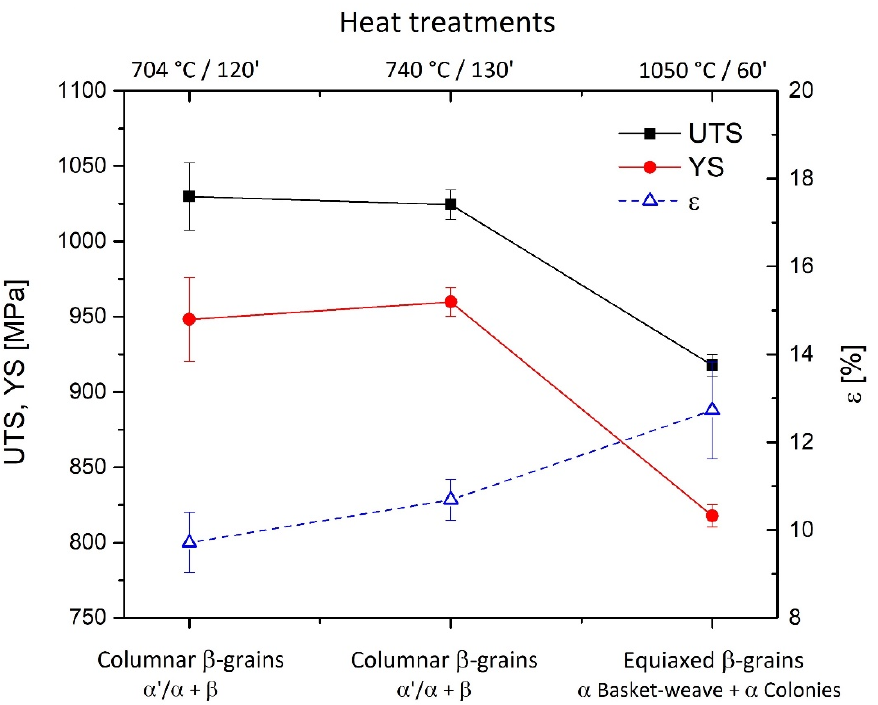
Figure 14. Average ultimate tensile strength, yield strength and elongation of the samples heat-treated at 704 °C/120 ′ , 740 °C/130 ′ and 1050 °C/60 ′ .